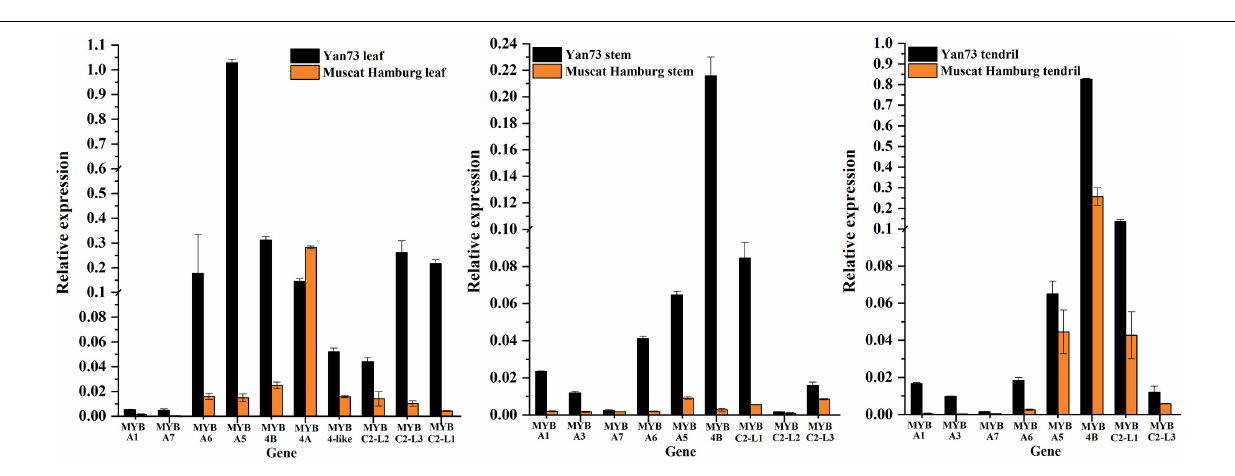
FIGURE 5 | Relative expression levels of transcription factor genes associated with anthocyanin biosynthesis in Yan73 and its male parent (Muscat Hamburg) leaf, stem, and tendril tissues. The data are derived from a qRT-PCR analysis and are normalized against VvUbiquitin expression data. Error bars illustrate the standard deviations for three biological